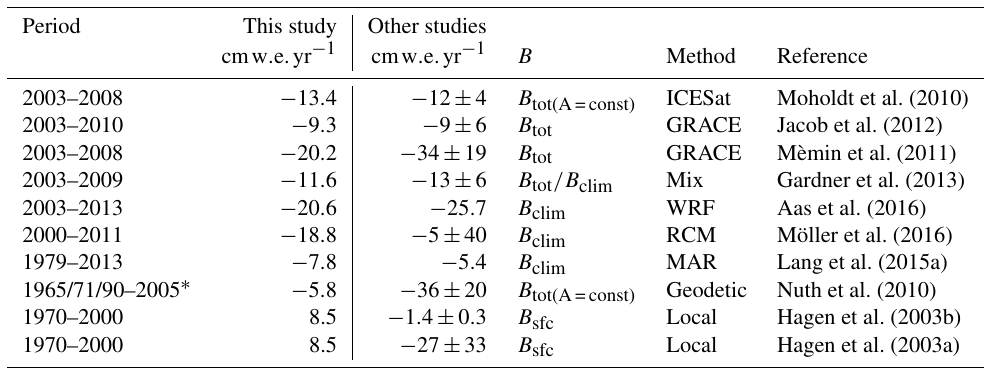
Table 10. Svalbard mass balance estimates from different studies and methods. Note that the numbers between the studies are not directly comparable due to difference in time periods, areal coverage and methodology. Mass balance method short names are as follows: ICESat, a laser altimetry from the Ice, Cloud and elevation Satellite; GRACE, a gravimetry using data from the Gravimetry Recovery and Climate Experiment; Mix, a combination of GRACE, ICESat and modelling; WRF, MAR and RCM, three different regional climate models; Local is direct glaciological measurements; see references for details. Gravimetry studies report total mass balance ( B tot ), which is the sum of climatic ( B clim ), basal balance ( B b ) and frontal ablation ( A f ), The geodetic studies report ( B tot ) by integrating elevation changes over a constant area ( B tot(A=const) ). Other studies report climatic mass balance ( B clim ) or surface mass balance ( B sfc ). Except for our study, the B clim and B sfc studies assume constant glacier area, though the glacier area may vary between studies.